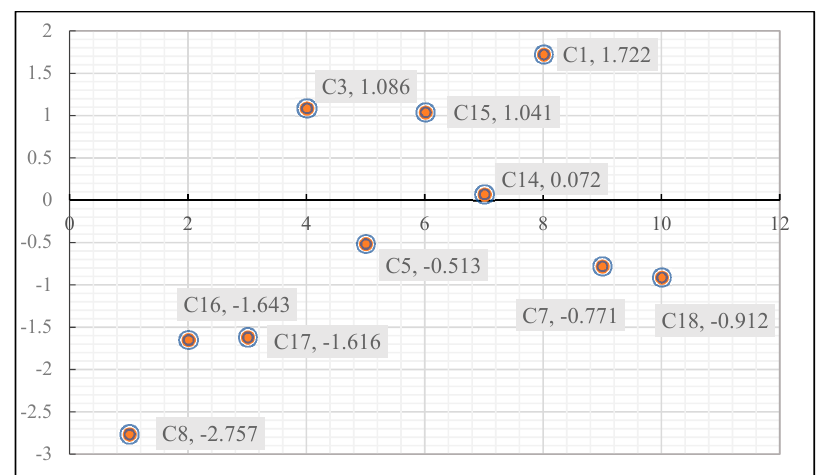
Figure 7. Top 10 criteria of risk factors.